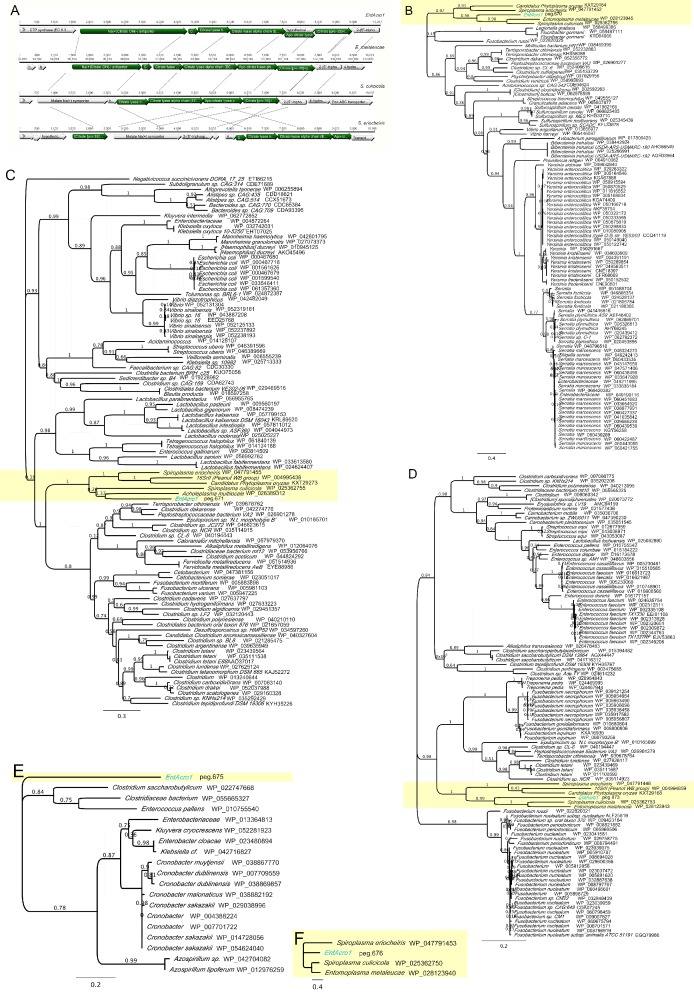
Citrate utilization genes in Mollicutes.(A) Schematic representation of the citrate catabolism operon in EntAcro1A, E. melaleucae, S. culicicola and S. eriocheiris. The combination of citrate utilization genes was only found in these four strains, that is, 2.3% of the 177 genomes examined). Arrows are proportional to the sizes (bp) of the genes, and the orientation of genes is captured by the arrowheads. Green-colored arrows refer to genes involved in citrate catabolism and gray arrows to genes that are unrelated to this pathway. Connecting lines between operons of different strains indicate gene rearrangements (only between S. eriocheiris associated with fly hosts and the remaining strains). All genes are presented with their common names as identified by RAST annotation: citS: citrate transporter (peg676); citC; citrate ligase (a.k.a. citrate pro 3 s lyase) (peg.671); citD, citE and citF; the three subunits of citrate lyase (alpha beta and gamma) (peg.673–675); citG: 2-(5''-triphosphoribosyl)−3'-dephosphocoenzyme-A synthase; however citG cannot be part of the potential citrate operon as it does not have the same orientation as the other genes. (B–F) Phylogenies based on amino acid alignments of the citrate utilization genes (B) peg.670, (C) peg.671, (D) peg.673, (E) peg.675 and (F) peg.676) in EntAcro1 and the top 100 hits (or fewer if there were no hits available) on NCBI (peg.674 produced no hits). For each hit we present the bacterial strain it originates from (italics) and the accession number on NCBI (regular font). Predicted Mollicutes proteins are highlighted with yellow background and EntAcro1 is written in blue. Support values are based on the Fasttree algorithm. Comparison of the GC content and the tetranucleotide frequencies of the citrate utilization genes (peg. 671, peg.673– 676) as well as upstream and downstream genes revealed no differences (with the exception of citS) suggesting that the citrate transporter genes that we analyzed are not part of a genomic island introduced by a recent Horizontal Transfer event.